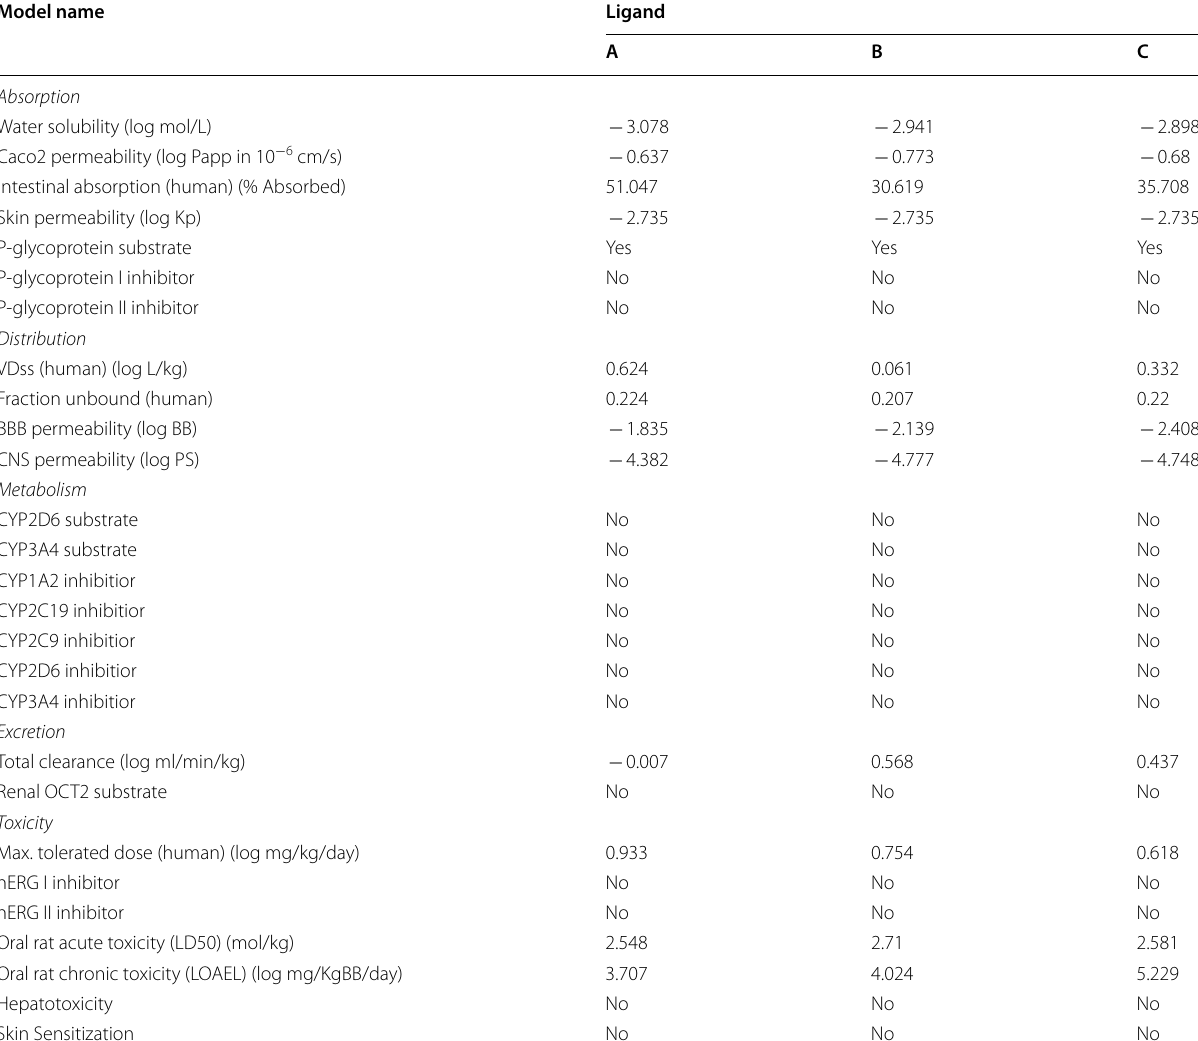
Table 2 ADMET prediction of three potent SARS-CoV-2 main protease (6YNQ)